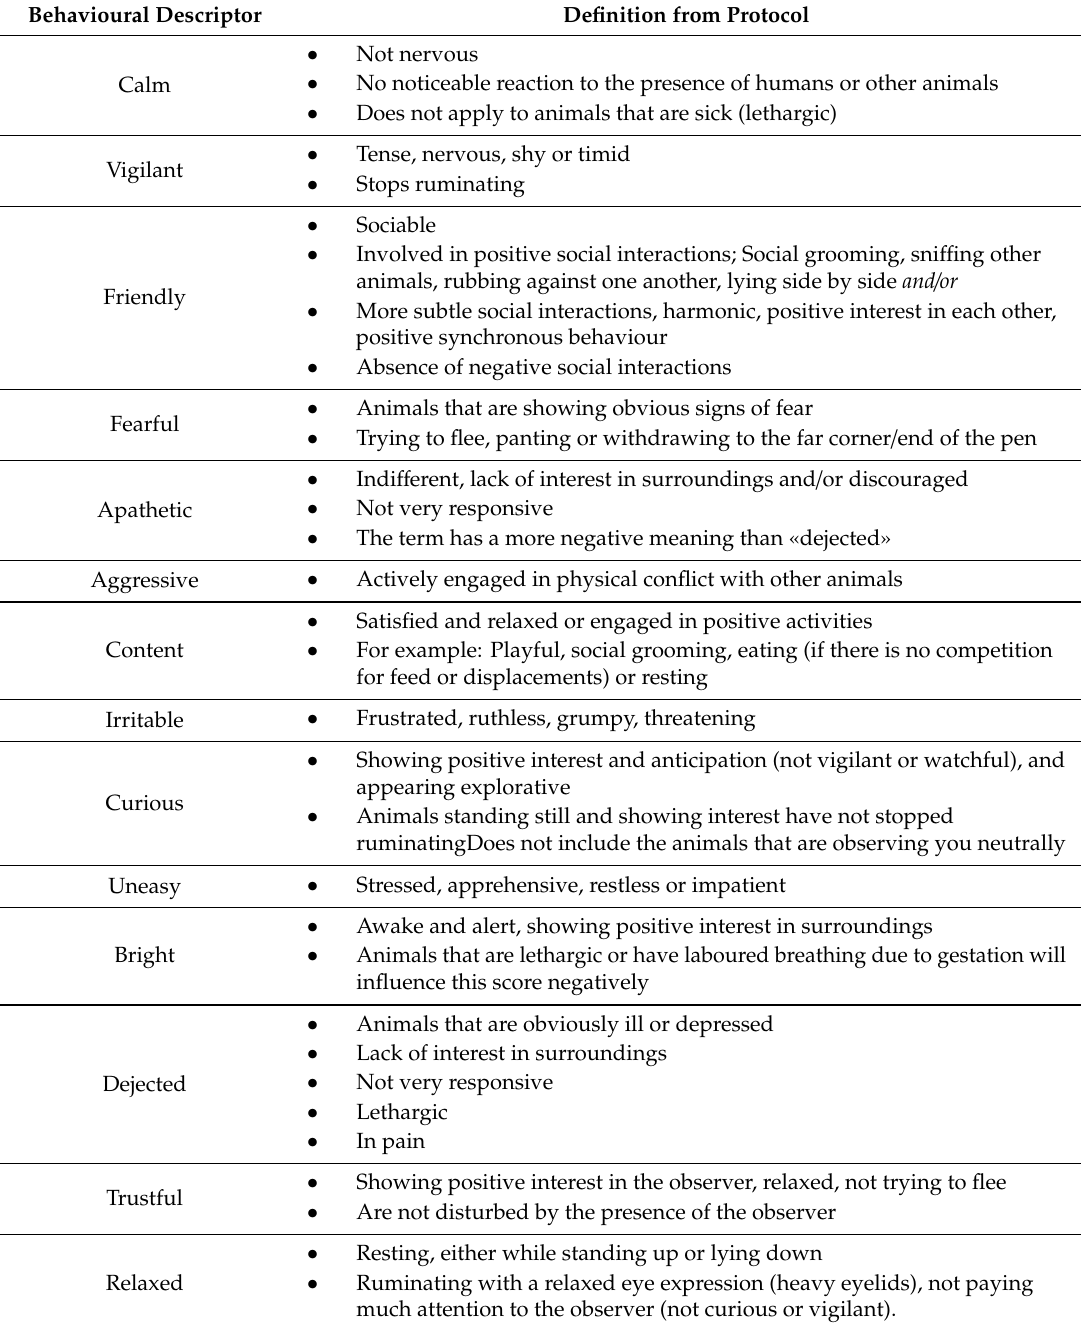
Table 1. The definitions used for the behavioural descriptors in this study. Behavioural